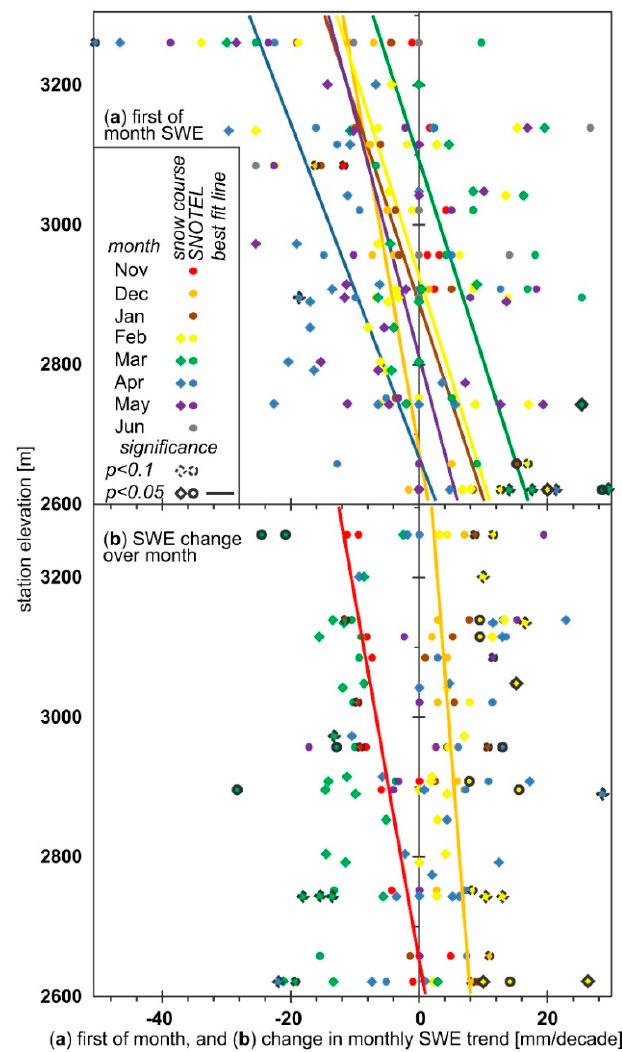
Figure 5. Correlation of monthly ( a ) snow water equivalent (SWE) trend, and ( b ) change in SWE with station elevation. Only significant correlations at the p < 0.05 confidence level are shown (solid line); no correlations are significant at the p < 0.10 confidence level. The statistics of these lines are summarized in Table 1a,b.